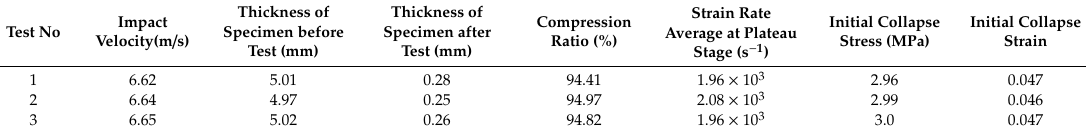
Table 4. The results of the dynamic compression tests under the strain rate 2 × 10 3 s − 1 .